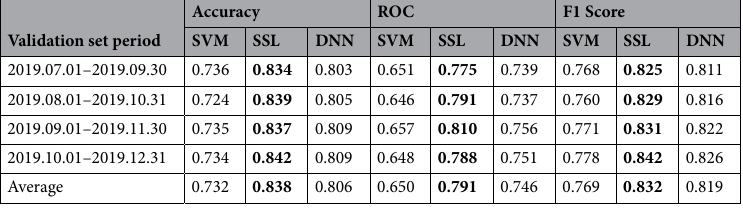
Table 1. Performance comparison using SVM, SSL, and DNN with training set using 6 months of data.